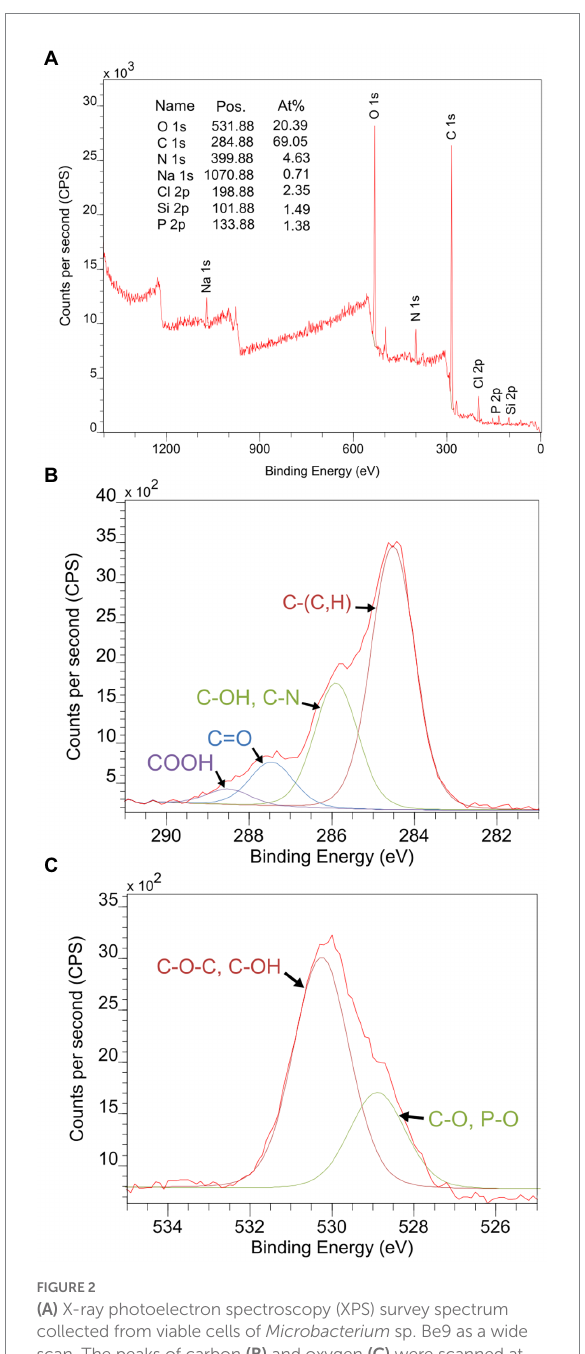
FIGURE 2 (A) X-ray photoelectron spectroscopy (XPS) survey spectrum collected from viable cells of Microbacterium sp. Be9 as a wide scan. The peaks of carbon (B) and oxygen (C) were scanned at high resolution and deconvoluted to assess the local chemical environment of these two